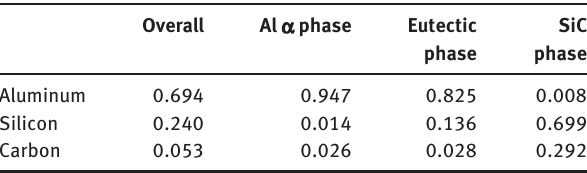
Figure 4 SEM micrographs of various Al foams obtained from the side surface of the samples; (A) a natural small cell (NSC), (B) an open one-side small cell (1SSC), (C) a natural large cell (NLC), (D) an open two-side large cell (2SLC), and (E) a sandwich composite enclosed by thicker skins (3D). Table 3 Phase percentages of aluminum, silicon, and carbon for the aluminum foam composite.